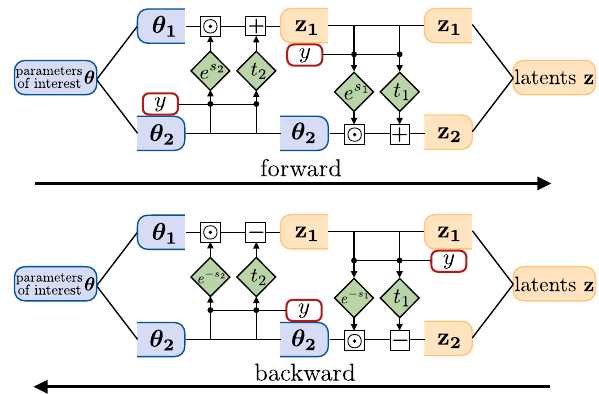
Fig. 4 Structure of the reversible block used for the conditional invert-